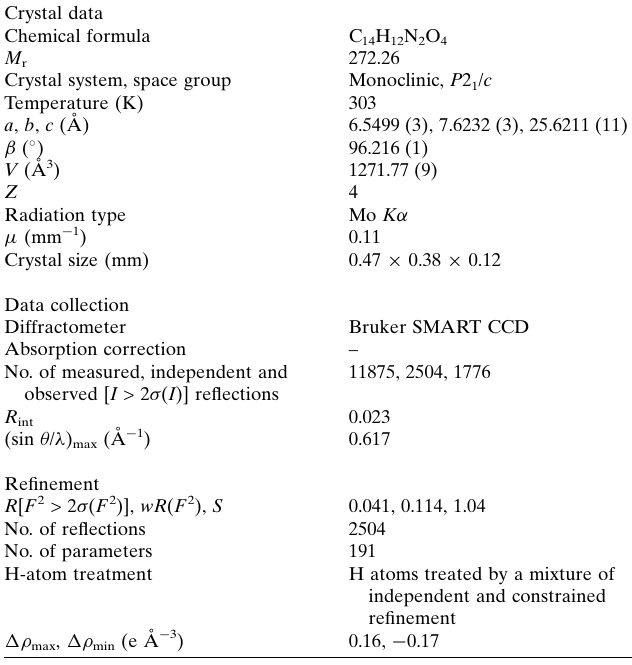
Table 2 Experimental details. Crystal data Chemical formula